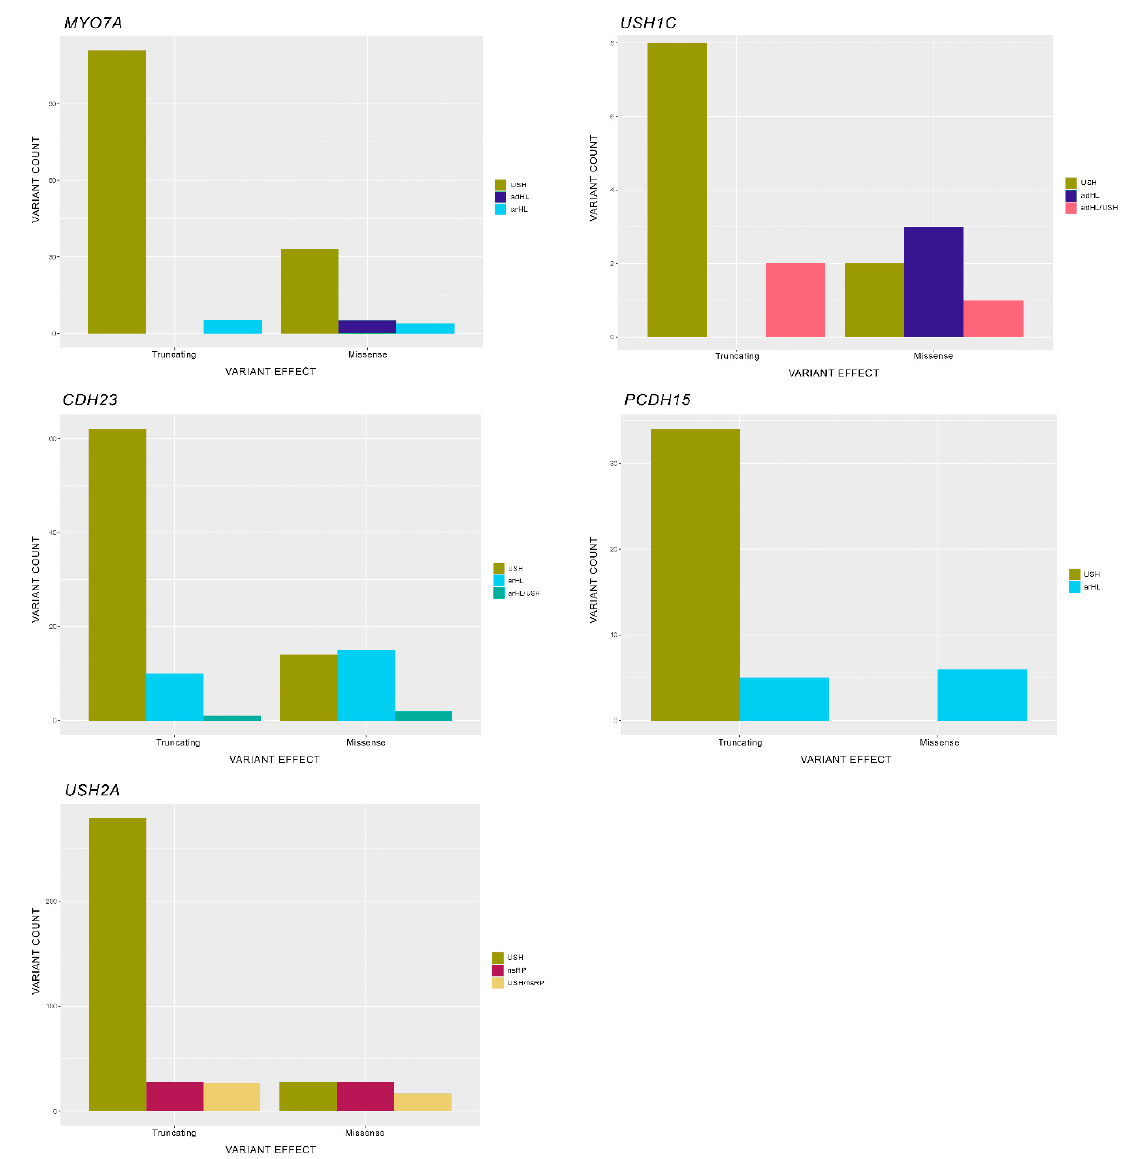
Figure 4. Mutational spectrum per gene for each phenotype. Abbreviations: USH, Usher syndrome; arHL, autosomal recessive hearing loss; adHL, autosomal dominant hearing loss; nsRP, non-syndromic retinitis pigmentosa. ADGRV1 is not included in the representation because all mutations obtained from the database were responsible for only USH and not for additional phenotypes.